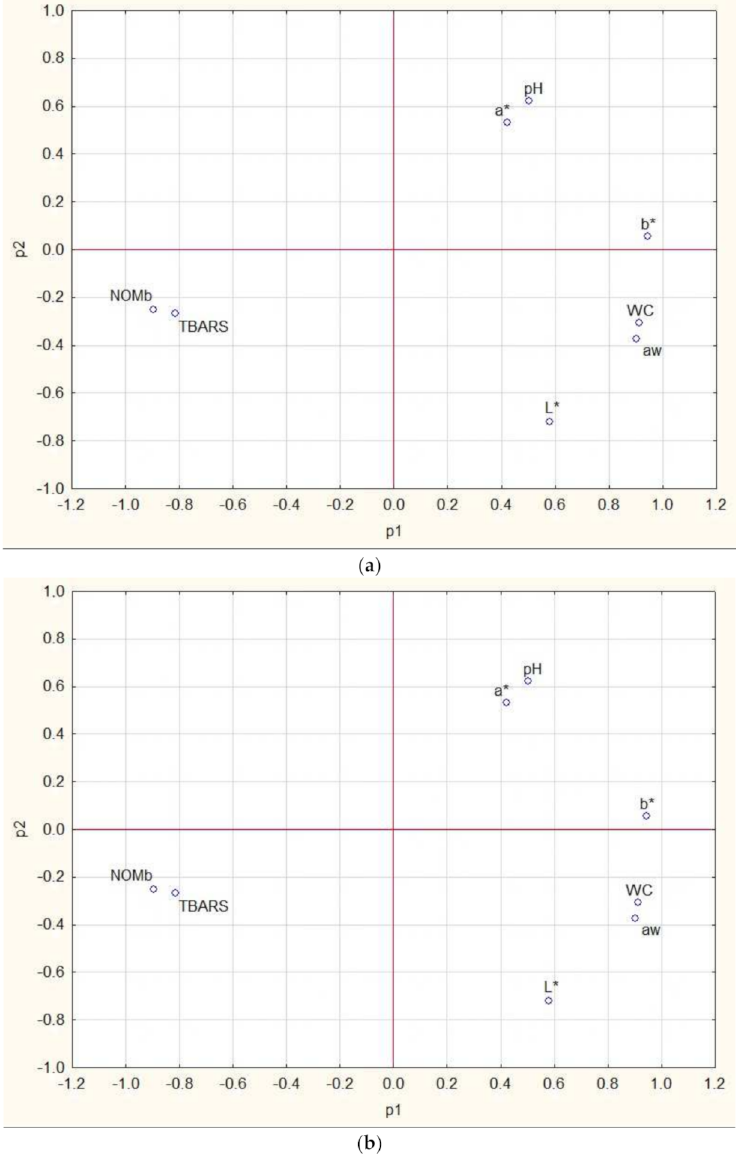
Figure 4. Loadings for the two principal components. ( a ) for samples with chia seed addition; ( b ) for samples with black cumin seed